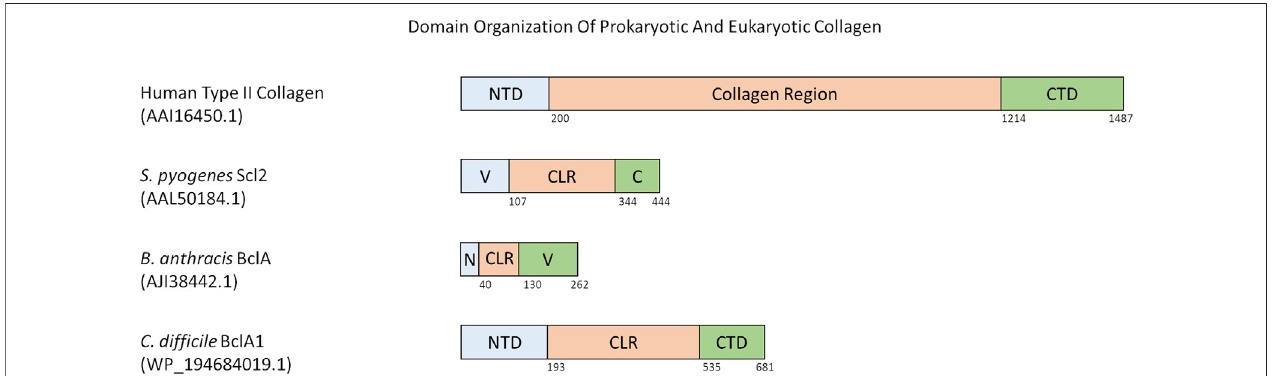
FIGURE 2 | Domain organization of various eukaryotic and prokaryotic collagens. All numbers in parenthesis below species name and protein name is the accession number for the protein as found in the NCBI Protein database. Numbers below the domains indicate the last residue of that domain. Abbreviations are as follows: NTD = N-terminal Domain, CTD = C-terminal Domain, V = Trimerization Domain, C = C-terminal domain and anchor to cell membrane, N = N-terminal Domain and anchor to cell membrane, CLR = Collagen-like